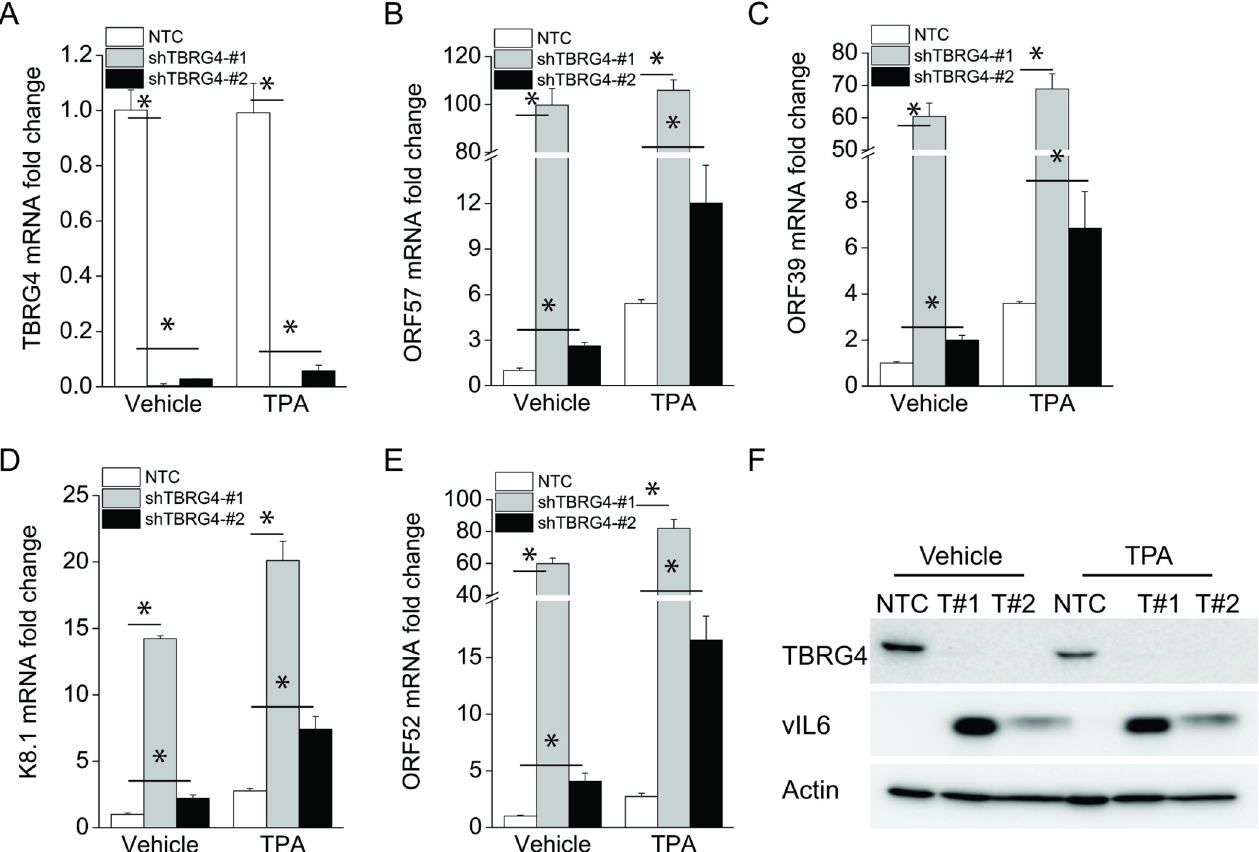
Fig 3. Suppression of TBRG4 induces KSHV lytic reactivation in PEL cells. BCBL1 cells were infected with lentivirus expressing a non-targeting shRNA, or two different shRNAs targeting TBRG4 for 5 d and then treated with 25 ng/ml TPA for 16 h. (A-E) RNA was extracted from the cells, and knockdown efficiency of TBRG4 and mRNA expression levels of the viral ORF57, ORF39, K8.1, and ORF52 was measured with real-time PCR and normalized to β -actin mRNA. (F) Cell lysates were collected and western blots were performed with indicated antibodies.